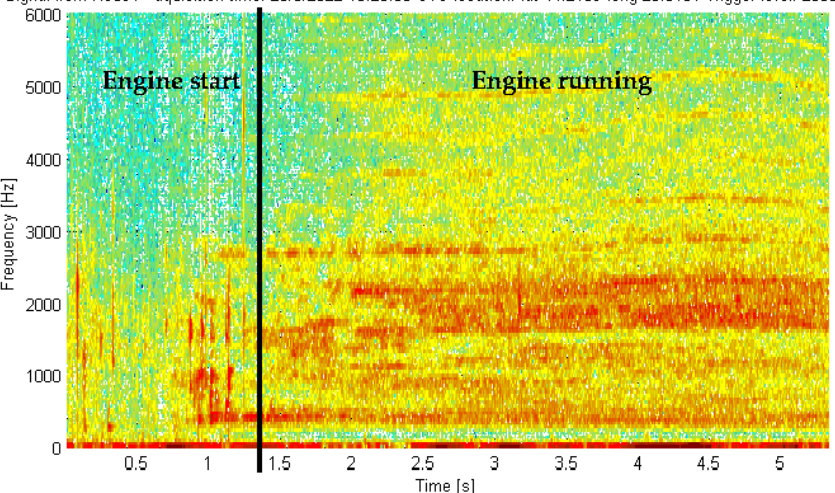
Figure 33. Signal picked up by a beacon in the presence of a motor boat.